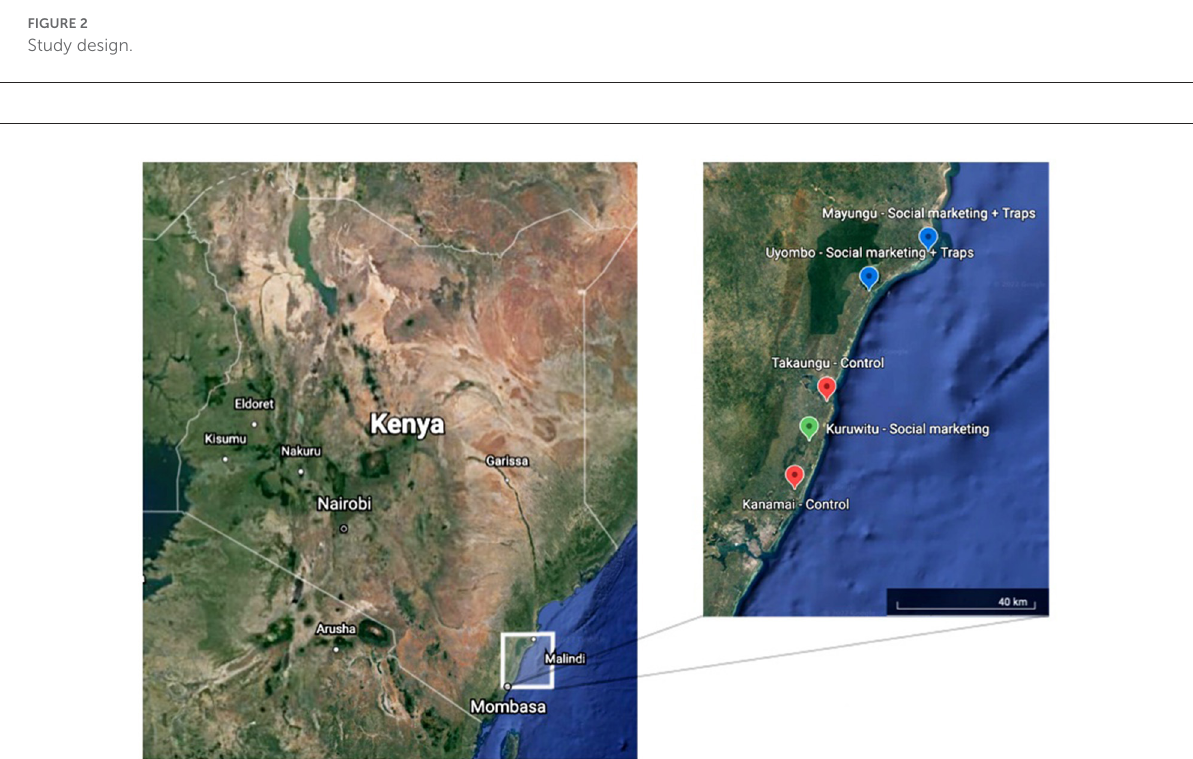
FIGURE3 Study area (Source: Google